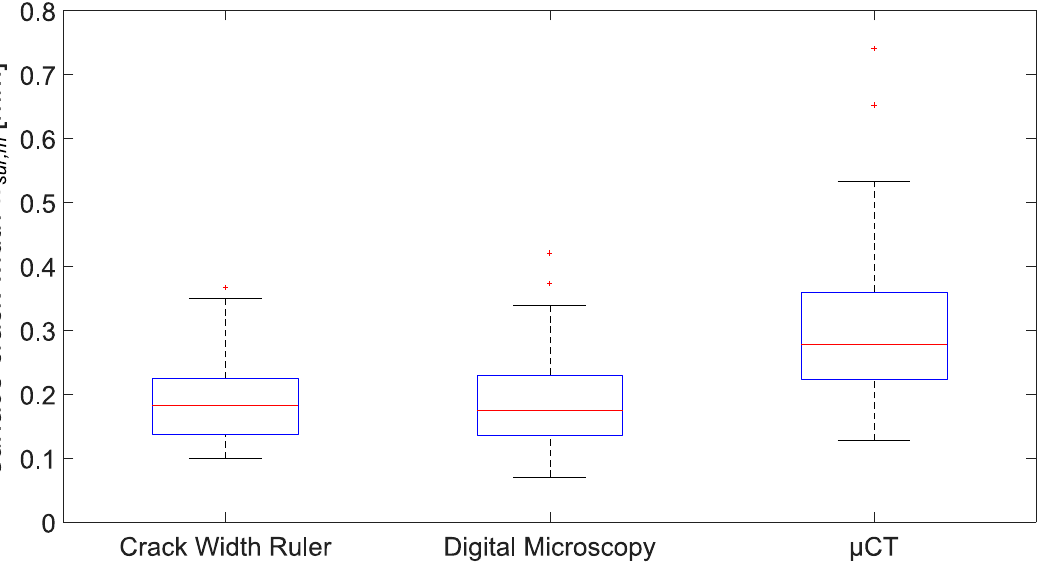
Figure 7. Comparison of surface-crack width results from different measurement methods (bottom and top edge of a box indicate the 25th and 75th percentiles, the band inside a box is the median, whiskers extend to the minimum and maximum data point within the 1.5 times interquartile range, a plus sign represents an outlier).